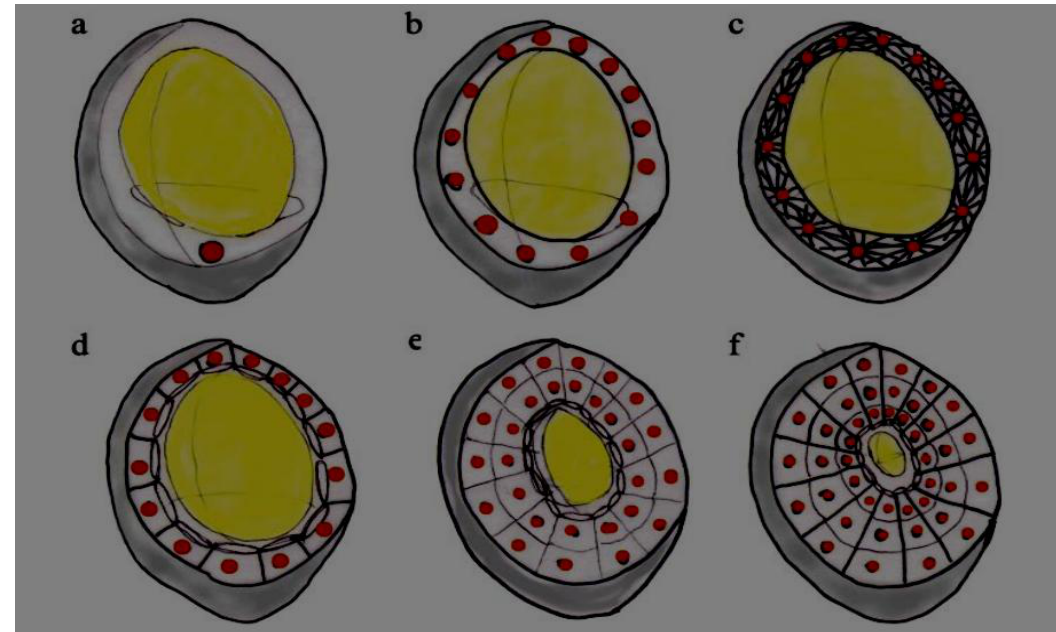
Figure 2. Diagrammatic representation of the cellularization process occurring in the developing endosperms of the Poaceae. ( a ) shows the fertilized triploid nucleus (orange) and central vacuole (yellow), ( b ), multinucleate cell with large central vacuole, ( c ), cellularization, formation of a radial microtubule system (RMS) emanating from the surface of endosperm nuclei, ( d ), cell wall formation; each nucleus is surrounded by a tube-like wall structure termed the alveolus, ( e ), continued growth of alveoli, and ( f ) mitotic division. Image adapted from reference [64].